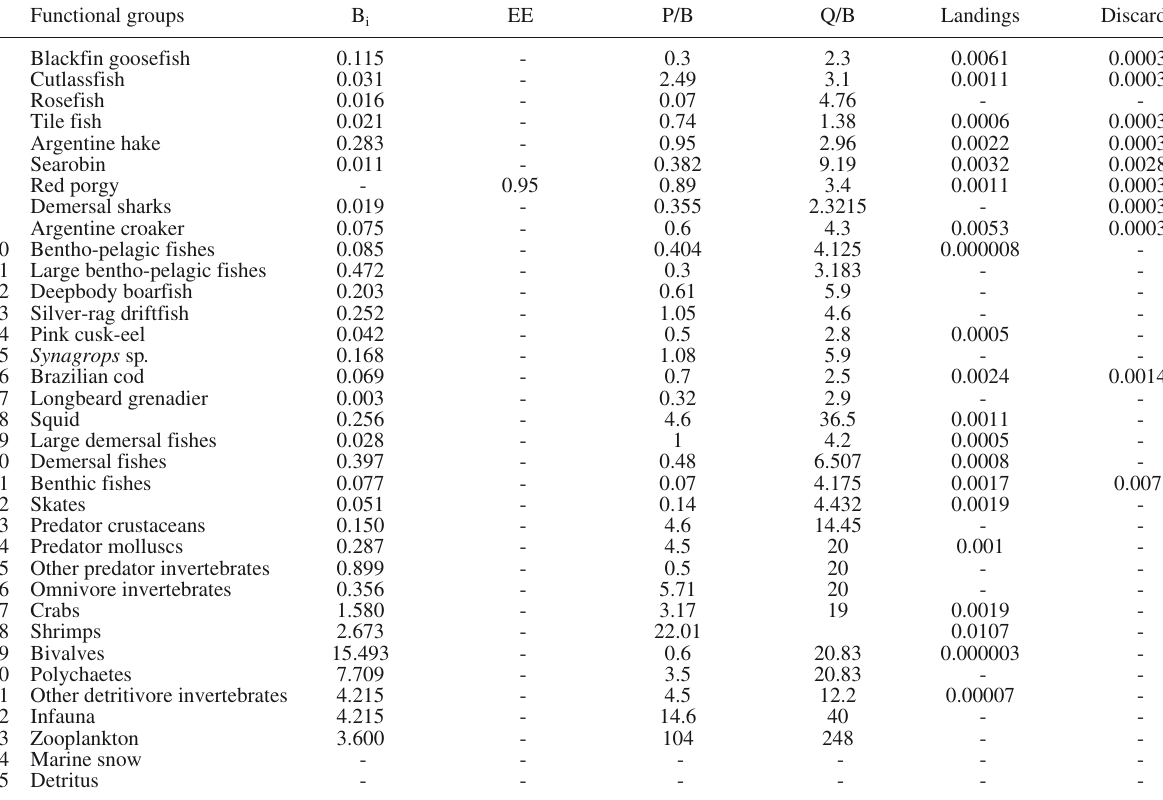
Table 2. – Input data. B , initial biomass (t km –2 ); EE, ecotrophic efficiency; P/B, production/biomass ratio (yr –1 ); Q/B, consumption/biomass i ratio (yr –1 ). Landings and discards in t km –2 yr –1 . Functional groups